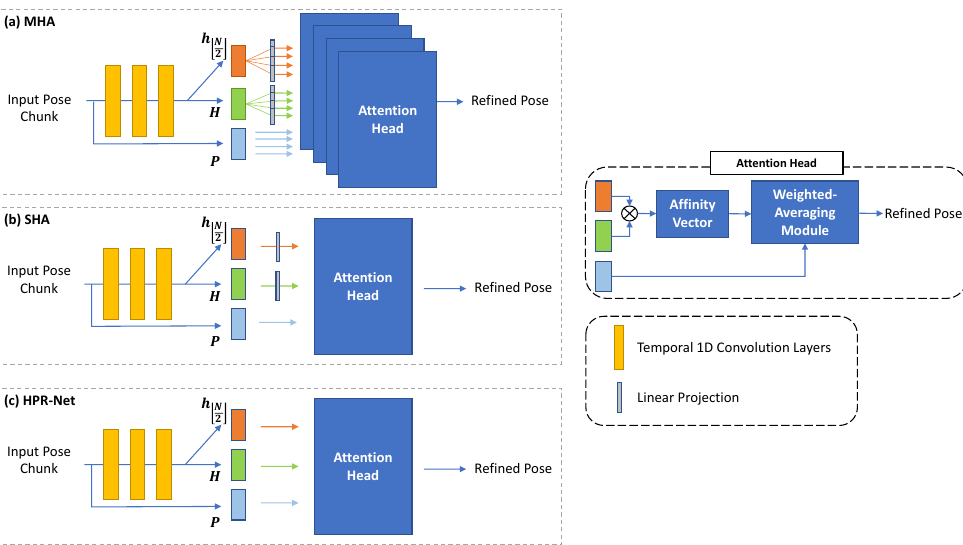
Figure 5. Detailed pipelines of multi-head structure ( a ), linear projection structure ( b ), and our proposed HPR-Net’s structure ( c ) for network design experiment. We did not apply linear projection to input pose chunk P in ( a – c ), because it should be averaged with affinity weights. Attention head contains affinity vector generation by self-attention and weighted-averaging